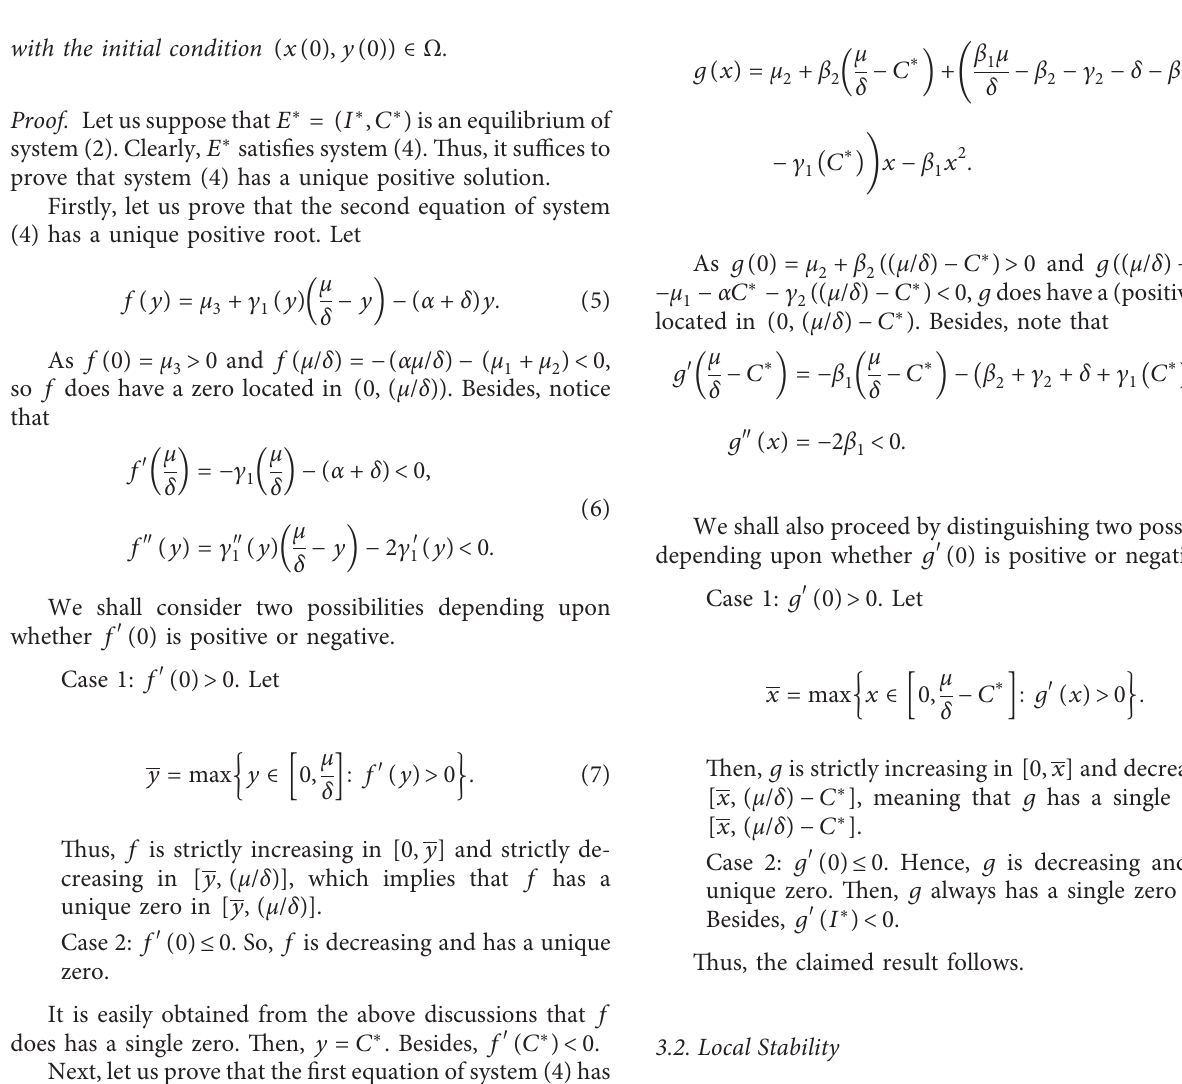
Figure 1: Transfer diagram of the new proposed